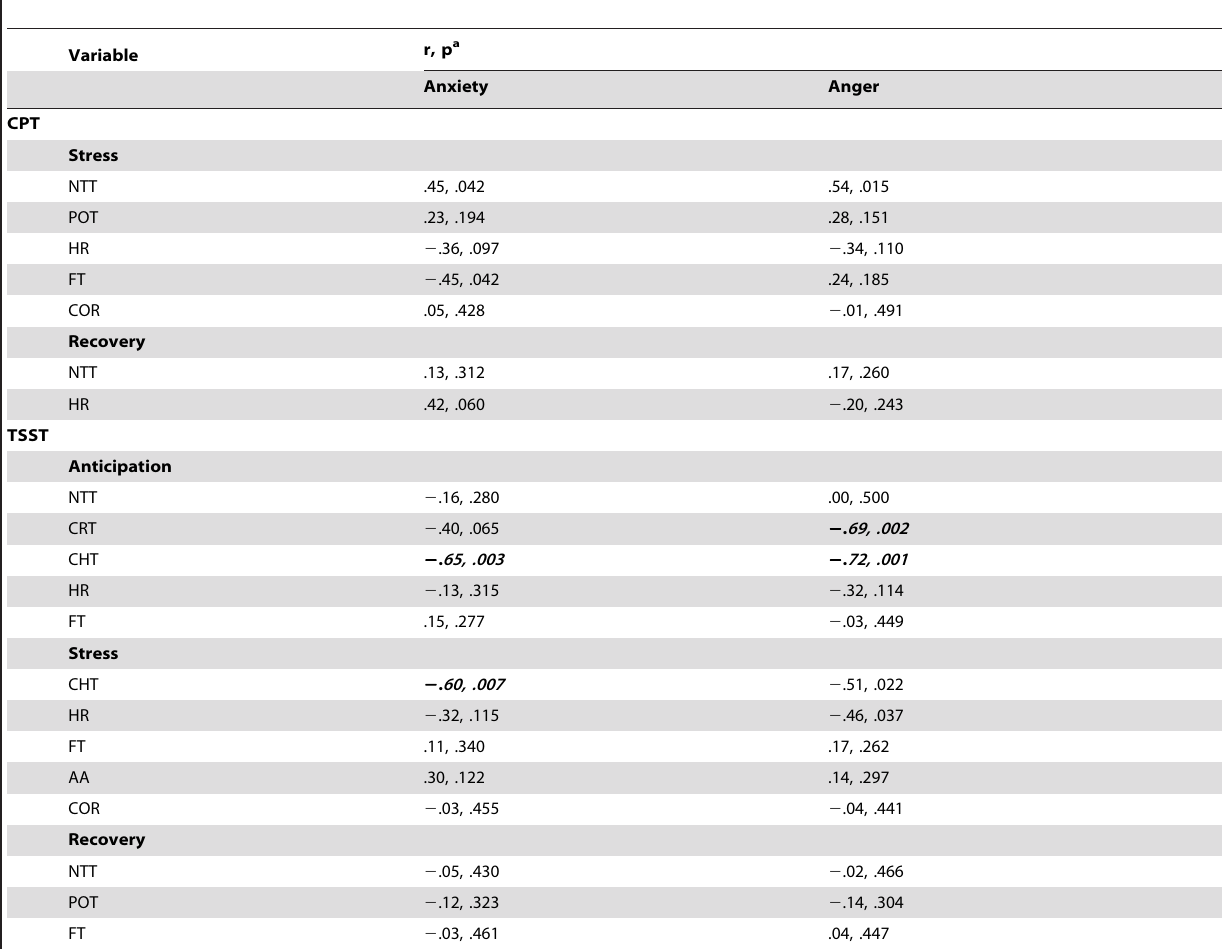
Table 4. Pearson correlations between the change-sensitive candidates and the anticipatory mood changes (anxiety and anger) per test phase in CPT and